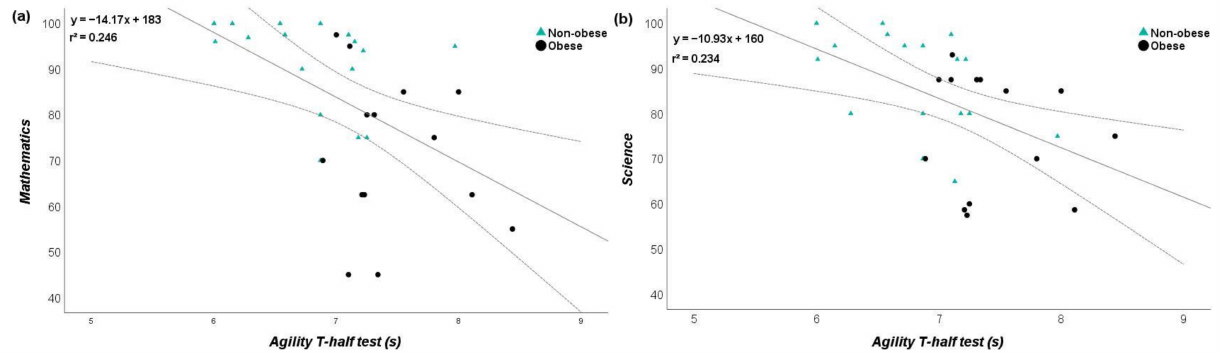
Figure 3. Relationship between ( a ) agility T-half test and mathematics and ( b ) agility T-half test and science. Please note that one dot can represent several